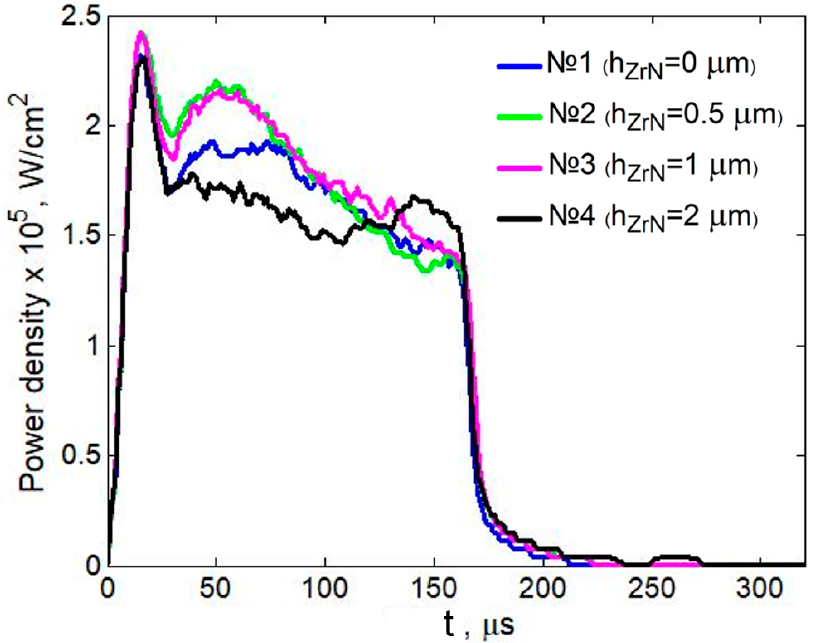
Figure 5. Time variations of the experimental power density during electron beam treatment for the bare and ZrN-coated silumin samples.